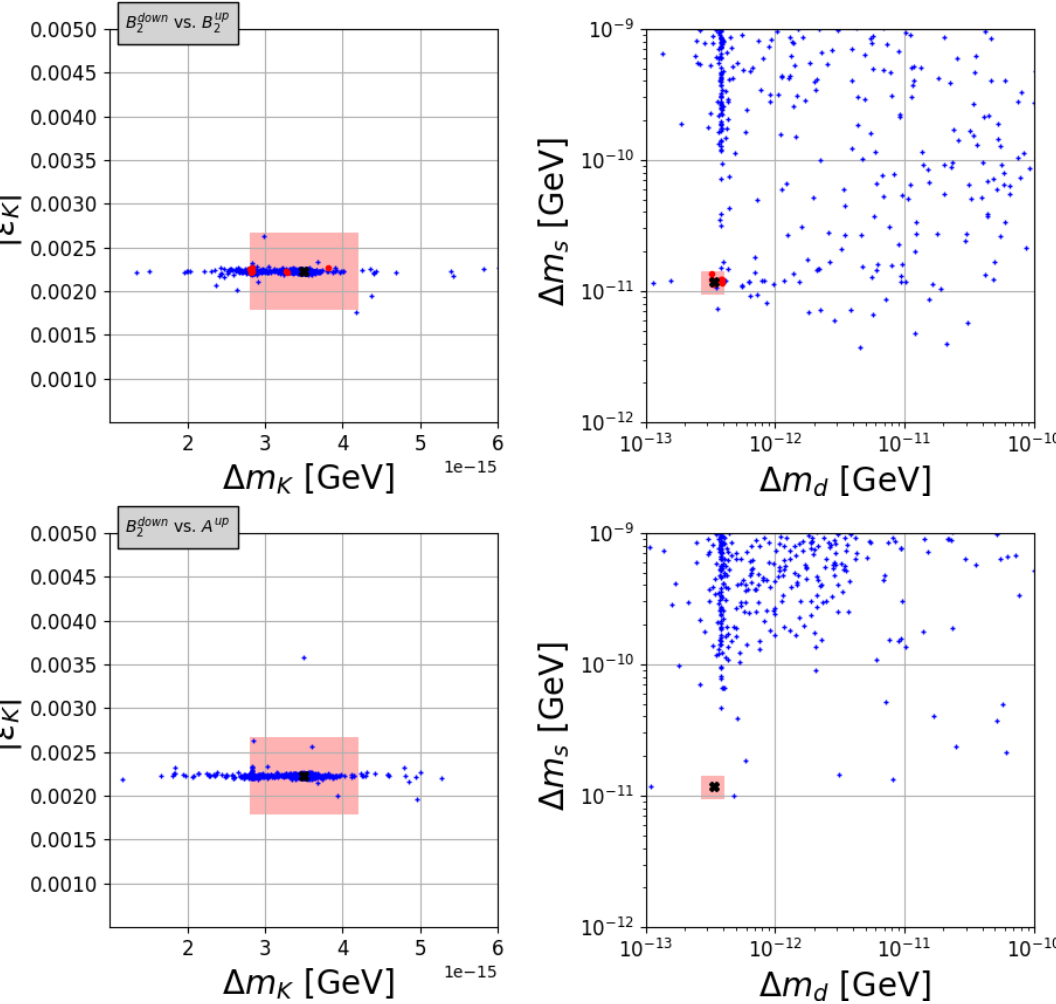
Figure 7 . Meson sector predictions for ( B 2 ; B 2 ) (upper) and ( B 2 ; A ) (lower)